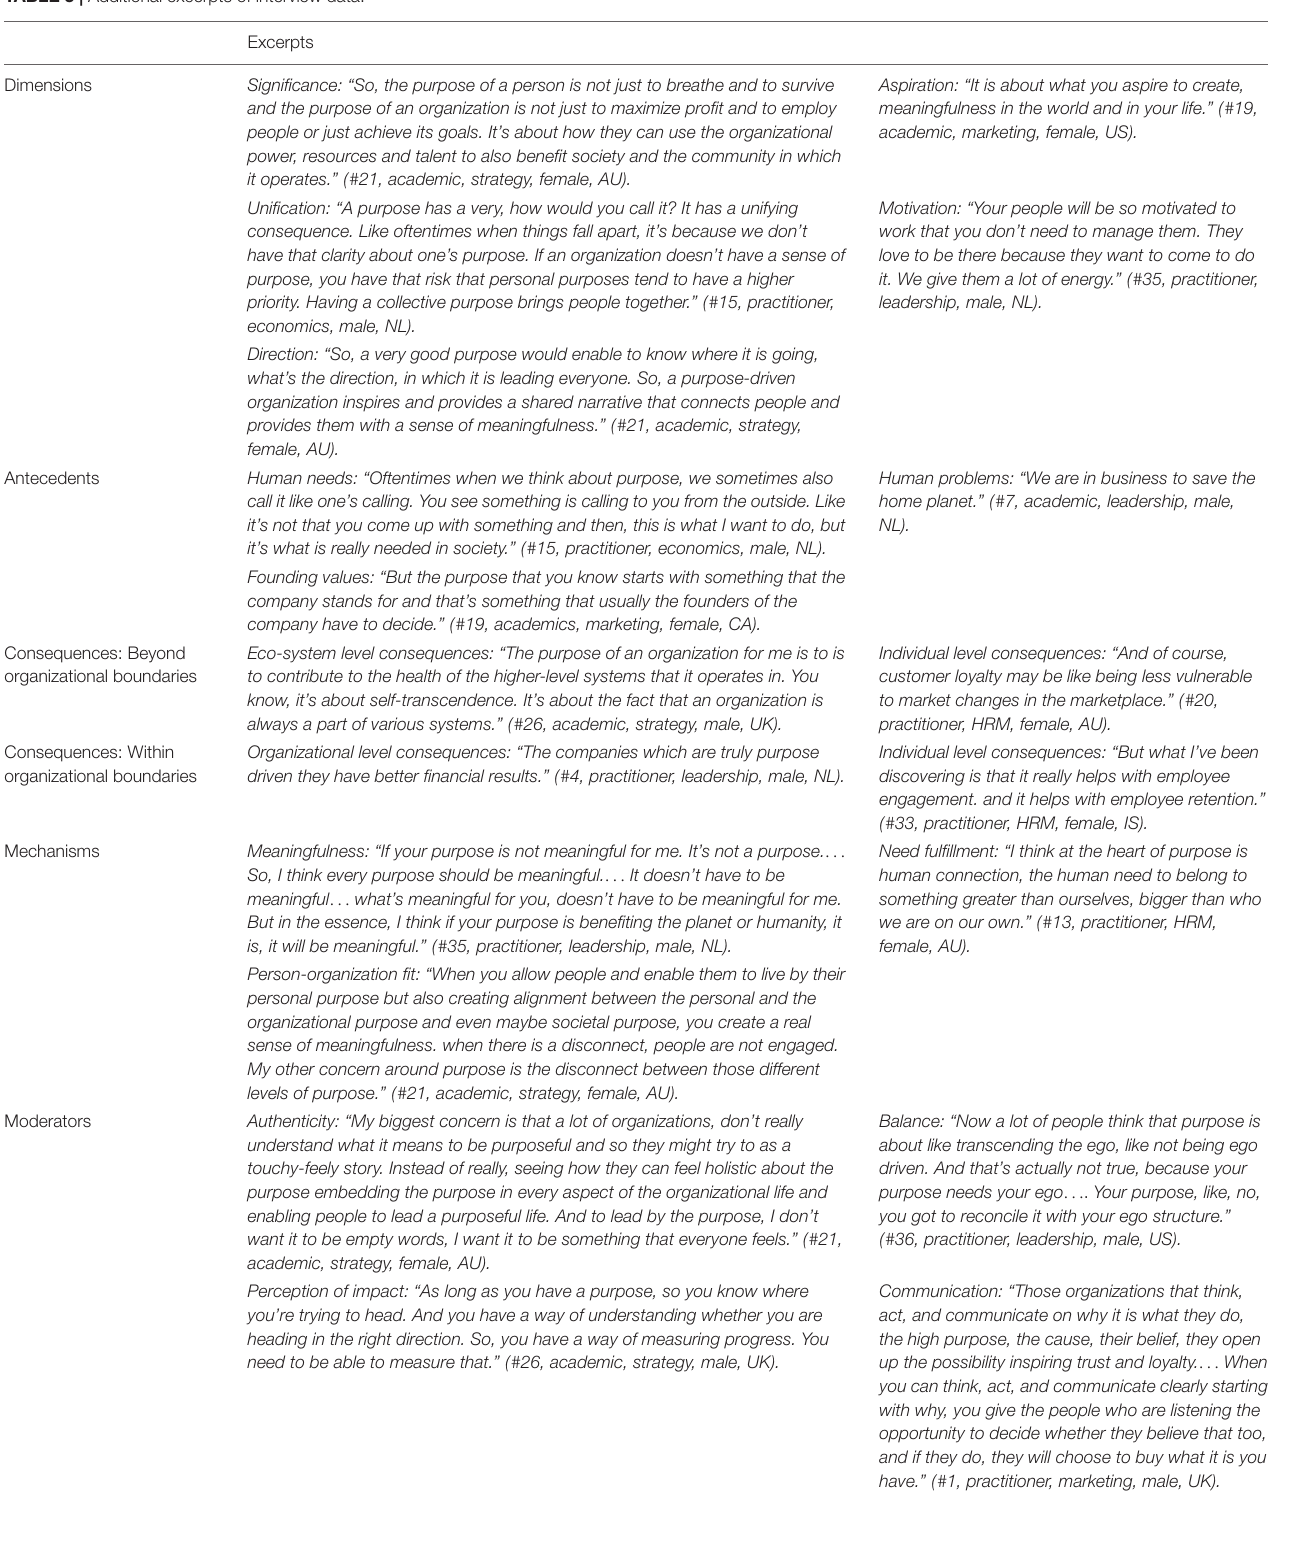
TABLE 3 | Additional excerpts of interview